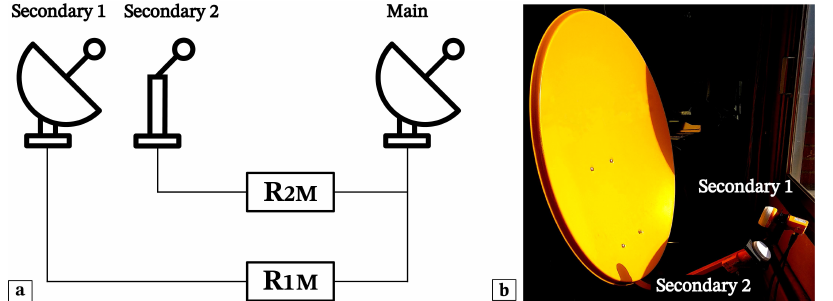
Figure 4. ( a ) The validation interferometer consists of two baselines. The correlation between the secondary receivers is performed with respect to the common main antenna. The first R 1 M baseline operates in nominal conditions. A second R 2 M baseline is added while getting rid of the reflector of the secondary antenna in order to test how the system works with an important Signal-to-Noise Ratio (SNR) degradation. ( b ) Secondary receivers’ detail. The first secondary receiver (corresponding to the nominal baseline) is pointed towards the reflector in order to have a proper SNR. The second secondary receiver feeder horn antenna is pointing directly towards the satellite, causing an important degradation in the SNR.